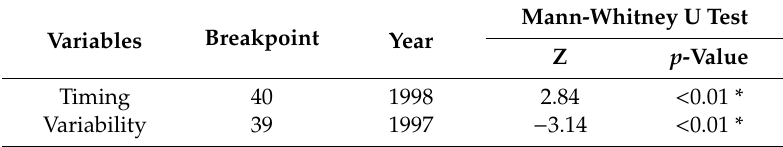
Table 6. Change point test in low flow regime components from 1959 to 2006. Mann-Whitney U Test Variables Breakpoint Year Z p -Value Timing 40 1998 2.84 < 0.01 * Variability 39 1997 − 3.14 < 0.01 * Note: * Significant at α = 0.05.